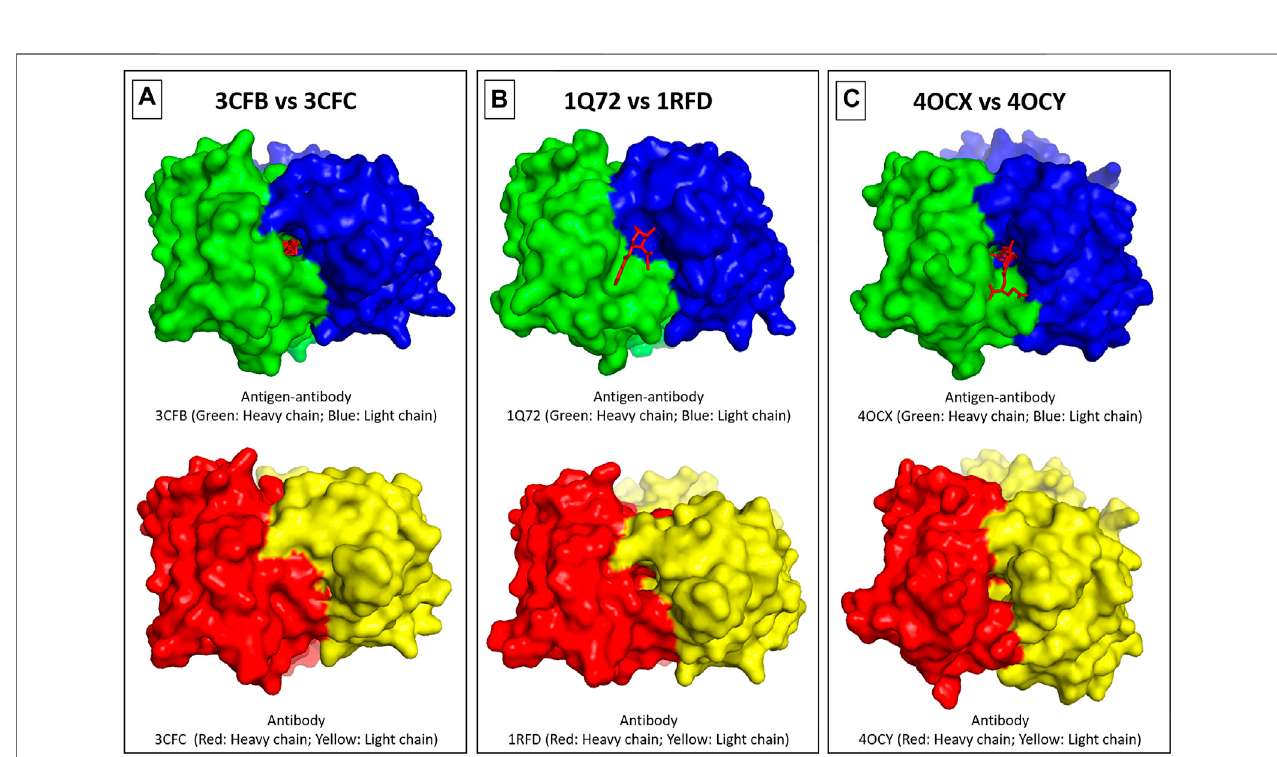
FIGURE2| Bindingsitessurfaces.Thebindingsurfacescanbegroupedintothreecategories.InS1,thereisapocketbindingsiteontheantibody-antigencomplex and notontheantibody-free counterparts,asshown in (A) .InS2,there isapocket bindingsiteon theantibody-free structure and notontheantibody-antigen complex, as can be observed in (B) . In S3, there is no (or only slight) change in the binding sites as shown in (C) . The heavy and light chains were colored as denoted in the fi gure, and the hapten antigen is shown as a red line